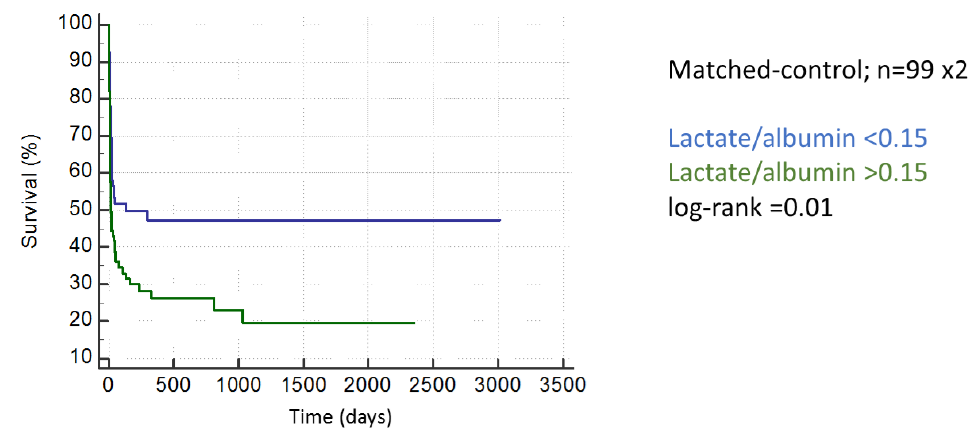
Figure 2. An increased lactate/albumin ratio is associated with long-term mortality in a matched- control